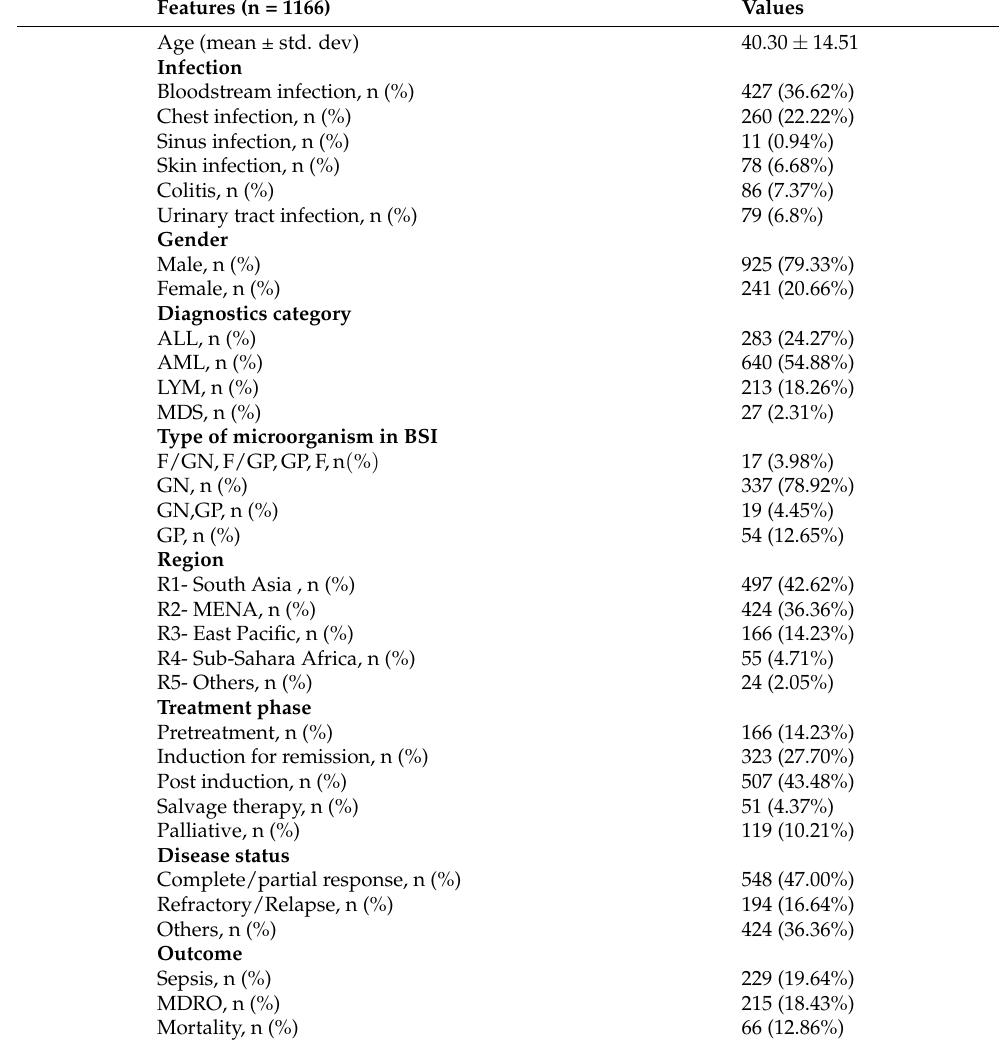
Table 1. Characteristics of potential features in the dataset, F: fungi, GP: gram-positive, GN: gram- negative, MENA: Middle East and North